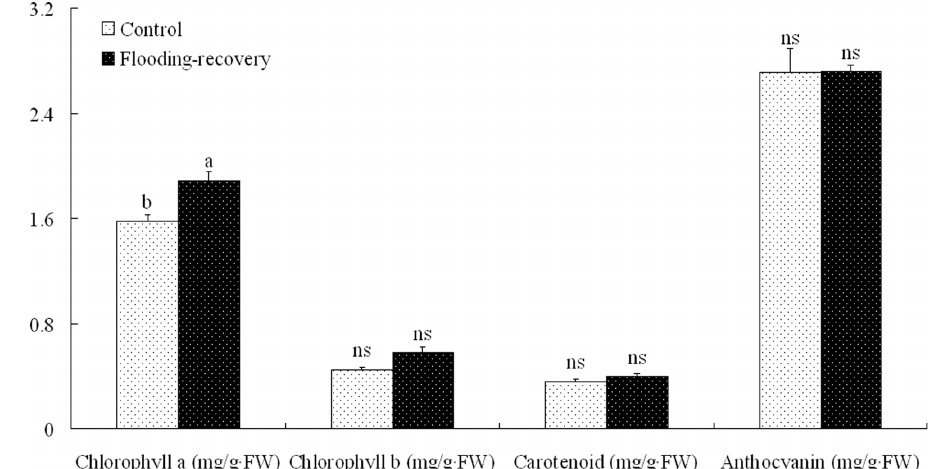
Figure 2. Comparable analyses of pigment contents in S.variegata during the recovery stage after winter floods. Values are means 6 SE ( n =6). The values followed by different letters significantly differed at P , 0.05 according to Duncan’s test. ns, no significant differences.